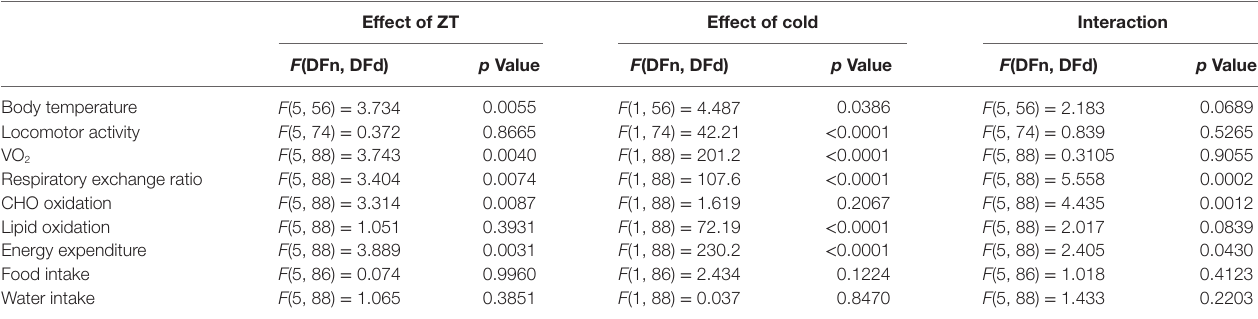
TaBle 3 | ANOVA two­way table (ZT × ambient temperature) demonstrating the effect of cold exposure and time of the day on net area under the curve (in arbitrary units for each parameter) for thermal, behavioral, and metabolic parameters. effect of